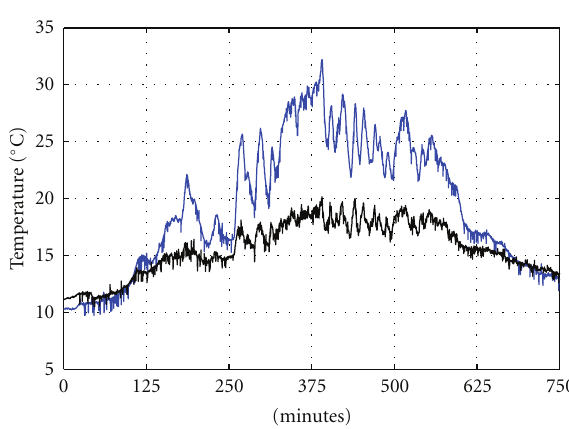
Figure 2: Di ff erence between inside and outside temperatures during daylight.